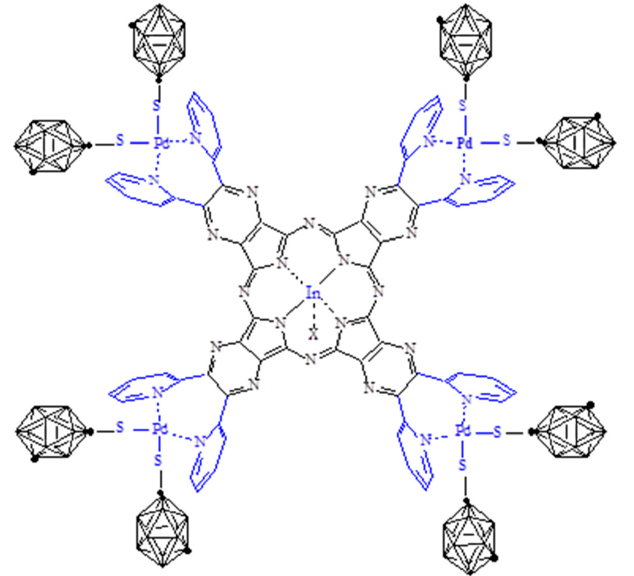
Figure 12. Schematic representation of the complex [{Pd(CBT) 2 } 4 Py 8 TPyzPzIn(OAc)]·19H 2 O (X = OAc − ). This heteropentanuclear species is obtained as a light green substantially amorphous (Figure S8), highly hydrated solid material by reaction of the parent pentanuclear complex [(PdCl 2 ) 4 Py 8 TPyzPzIn(OAc)]·8H 2 O with m- carborane-1-thiol (Section 2), this implying full